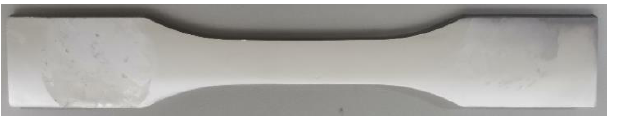
Figure 1. Shape and size of tensile and fatigue specimen. (Unit: mm).